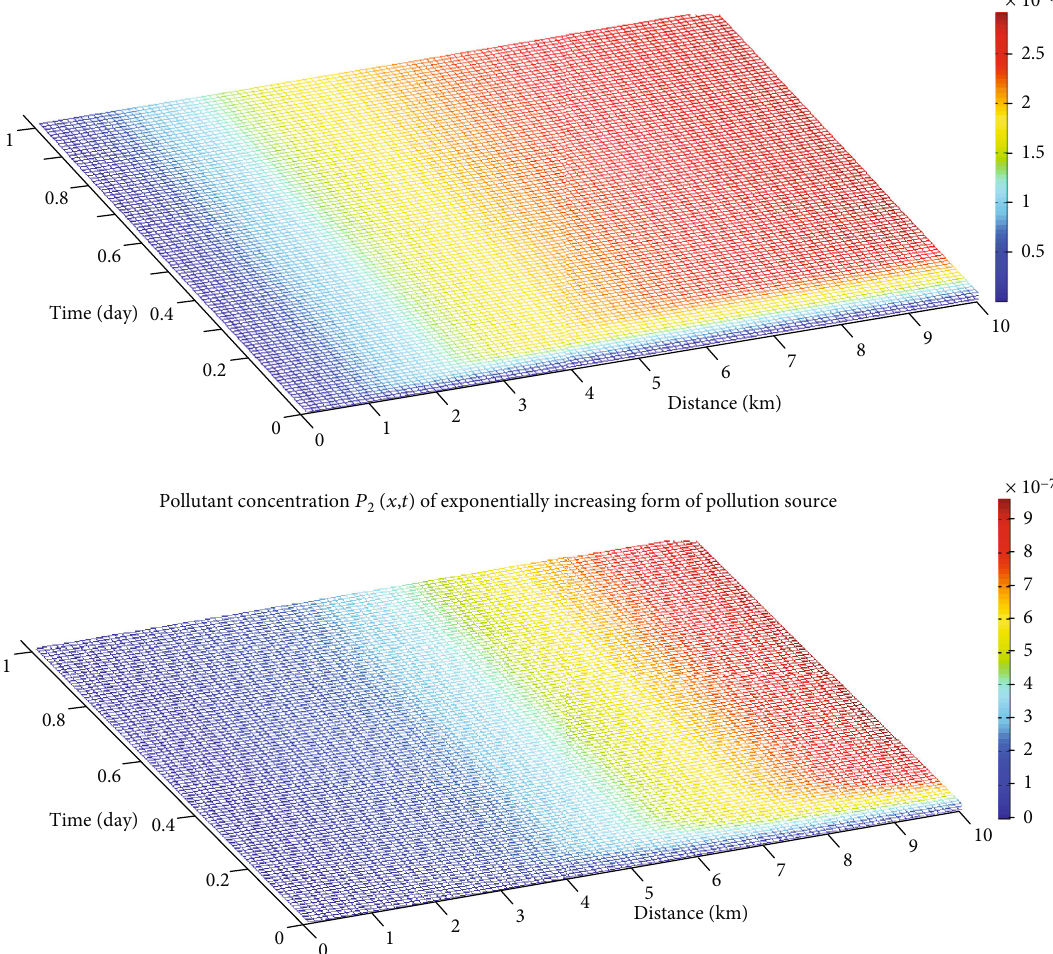
Figure 5: Pollutant concentrations P